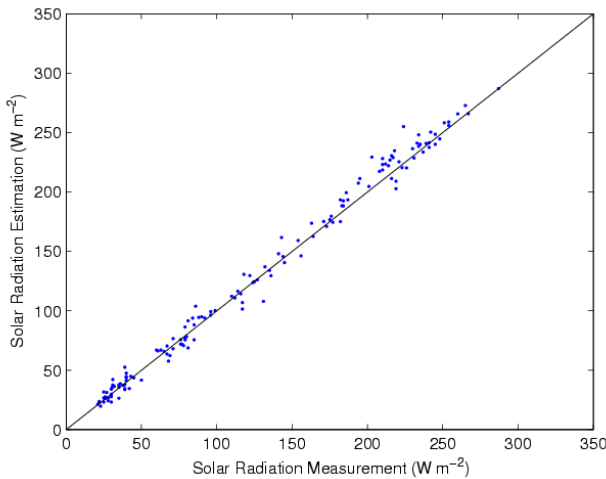
Fig. 2. An example of the comparison between monthly averages of solar radiation ( R s ) measurements and our prediction from SunDu at GEBA station No. 1193 (Kucharovice, CZECH REPUBLIC, see Table 1). More information on other stations is available in Table 1. lected where GEBA R s and SunDu data overlap for at least 84 months from 1982 to 2008 (Table